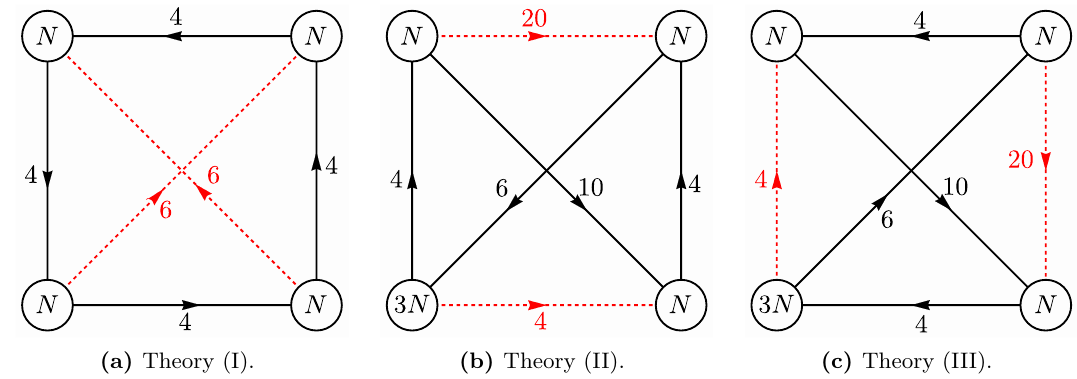
Figure 7 . Three N = (0 ; 2) quiver theories describing N D1-branes at the resolved orbifold ^C 4 = Z 4 (1 ; 1 ; 1 ; 1). The numbers denote the multiplicities of the arrows. From Theory (I) to